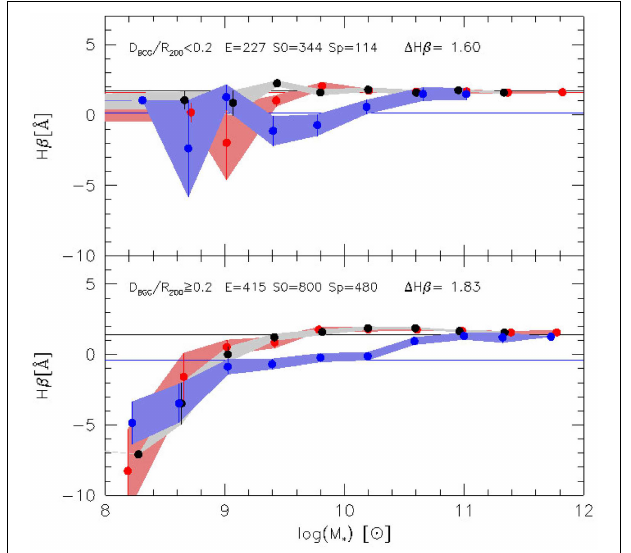
FIGURE 14 | The Lick index H β for galaxies closer to the center of the clusters and for more distant objects.